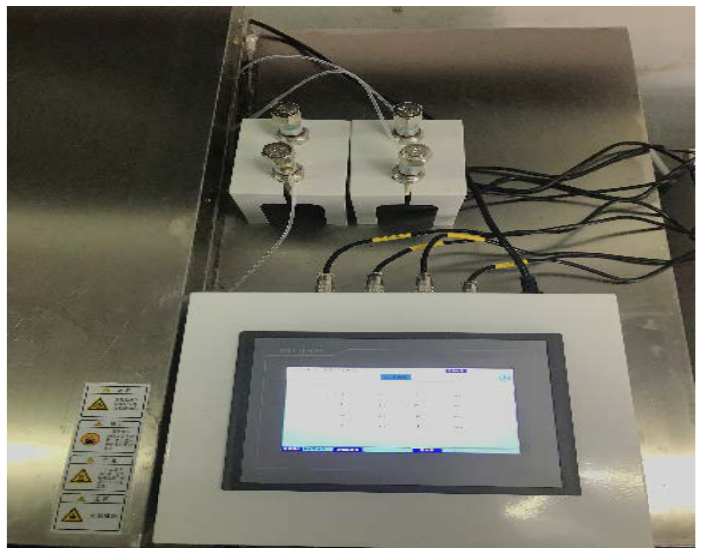
Figure 2. Capillary negative pressure instrument.